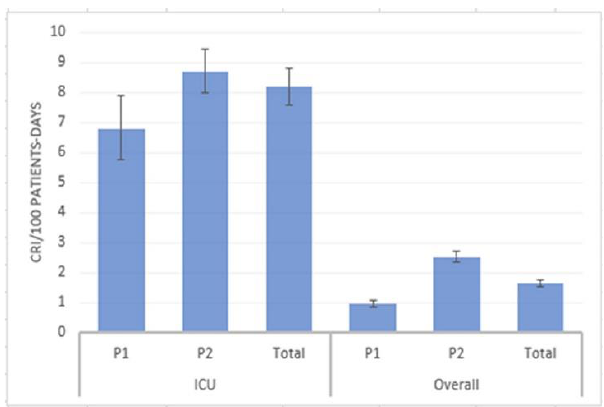
Figure 1: Comparison of incidences of carbapenem-resistant isolates between periods in the Intensive Care Unit wards and overall. Incidences are shown as CRI per 100 patients-day (blue bars) with 95% CI (black